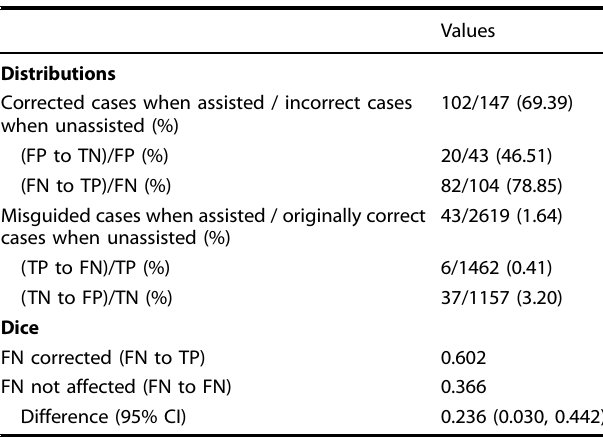
Table 6. Details of the CAD